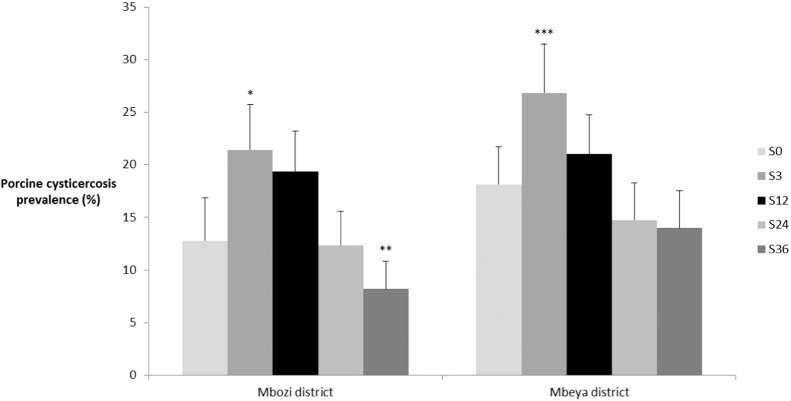
Porcine cysticercosis prevalence in the two districts Mbozi and Mbeya, Tanzania at Feb-Apr 2012 (S0), Oct-Nov (S3), Jul-Aug 2013 (S12), Jul-Aug 2014 (S24), and Jul-Aug 2015 (S36). Asterisk (*) marks significant difference with baseline (S0) based on logistical regression with *p = 0.01–0.05, **p = 0.001–0.009, and ***p < 0.0001. Error bars depict the 95% binomial confidence intervals based on number of positives and sample size.